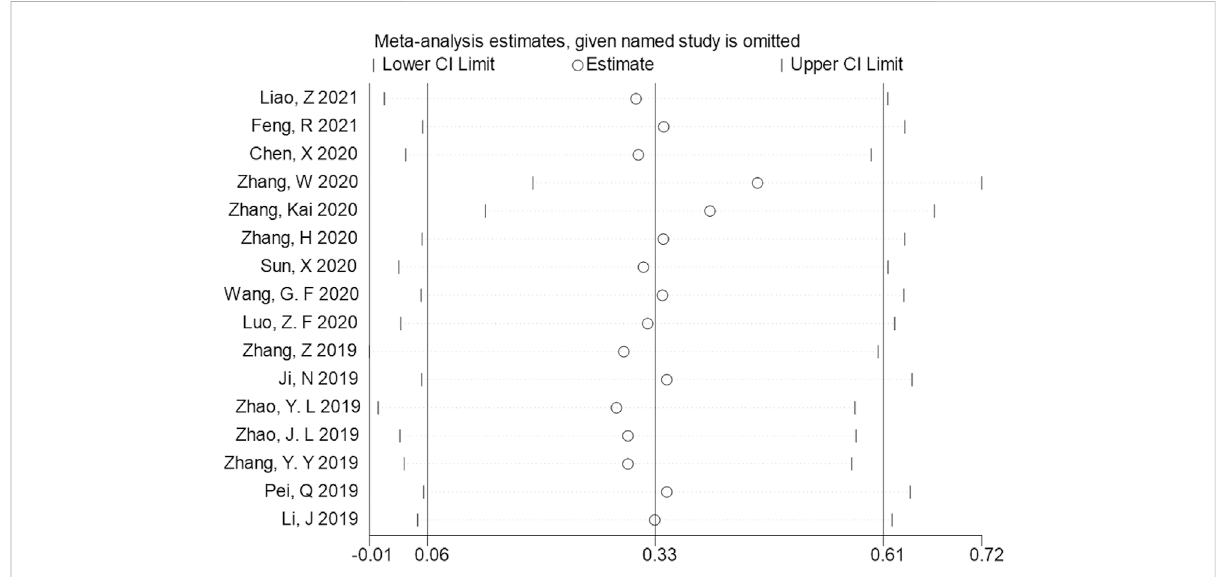
FIGURE 5 Sensitivity analysis for studies about OS by omitting each study